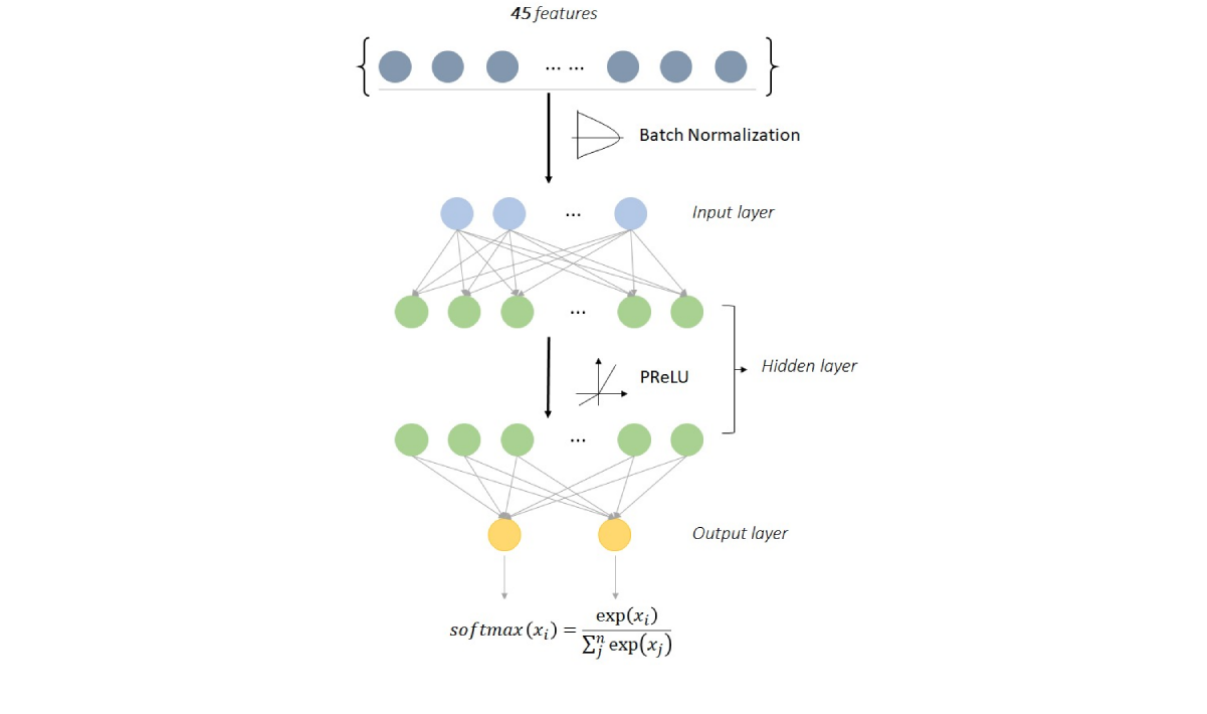
Figure 9. Deep neural network model architecture. PReLU: parametric rectified linear